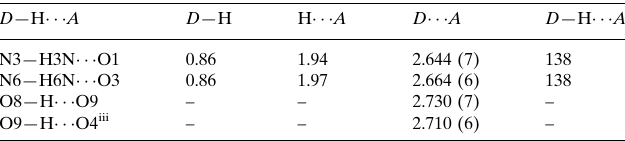
Hydrogen-bond geometry (A˚ , (cid:2)